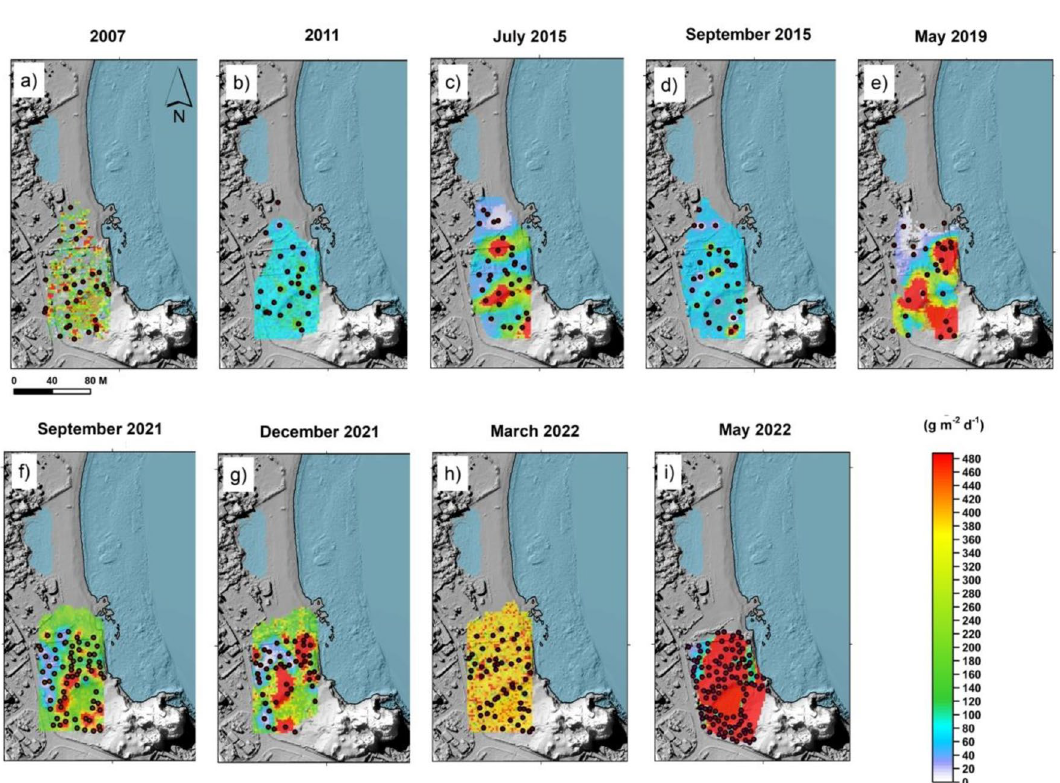
Figure 4. CO 2 flux maps of Levante Bay area (in g m −2 d −1 ) obtained by the sGs from September 2007 to May 2022. The black dots are measurement points. The maps were generated by Surfer Software Version 11.6.1159 Surface Mapping System (http:// www. golde nsoft ware.